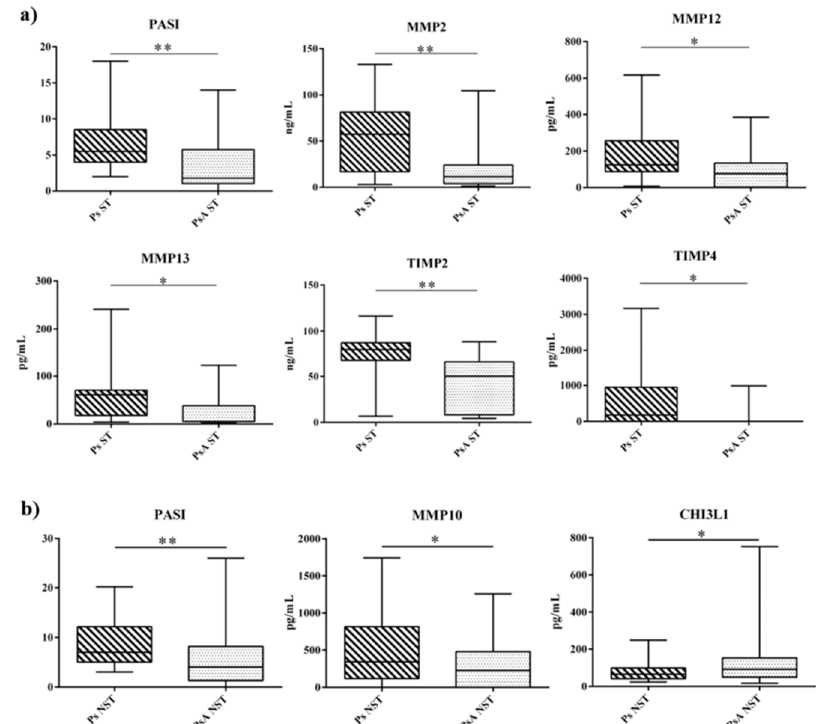
Figure 1. ( a ) Changes in PASI and serum profile of osteoimmunological markers in Ps ST group (hashed box) and PsA ST group (gray box). ( b ) Changes in PASI and serum profile of osteoimmunological markers in Ps NST group (hashed box) and PsA NST group (gray box). The box and whiskers plot identify, respectively, the value of the median (intermediate line), the 25th and 75th percentile (box), and the minimum and maximum value (whiskers). Asterisks indicate significant intergroup di ff erences (* p < 0.05, ** p < 0.01). CHI3L1: Chitinase-3-like protein 1, MMP: Matrix metalloproteinases,